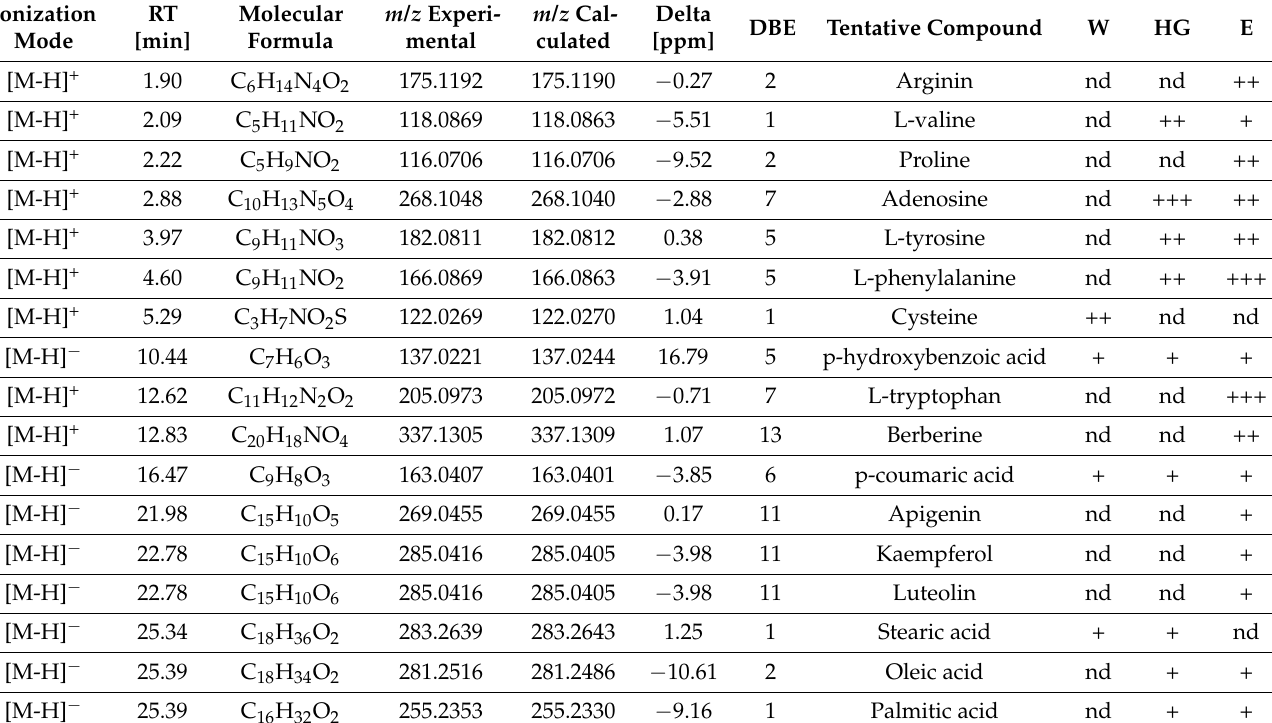
Table 3. The tentatively identified compounds in C. maxima ‘Hokkaido’ peel